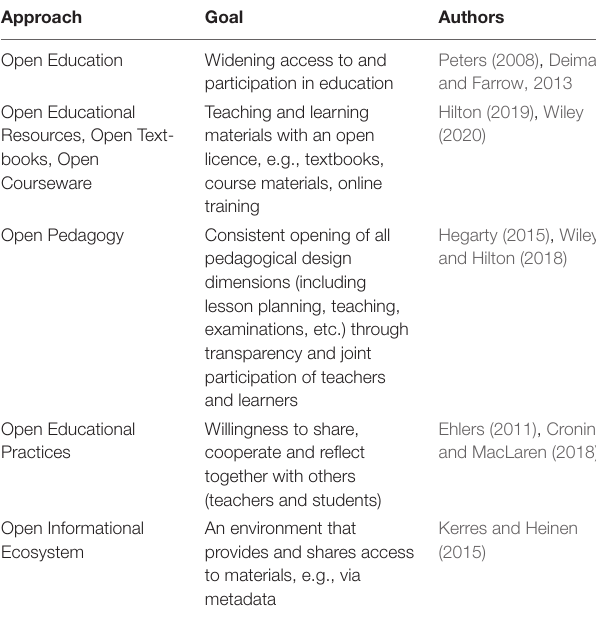
TABLE 1 | Current approaches in the context of open